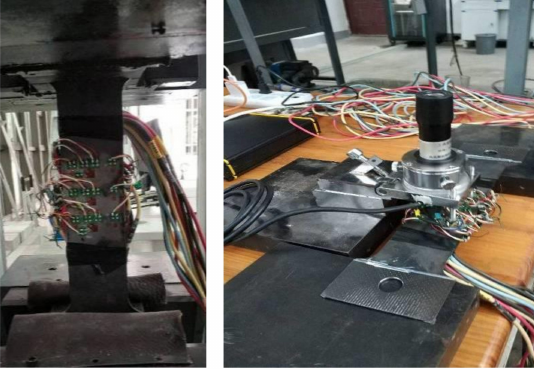
Figure 4. Calibration specimen strain rosette’s layout.